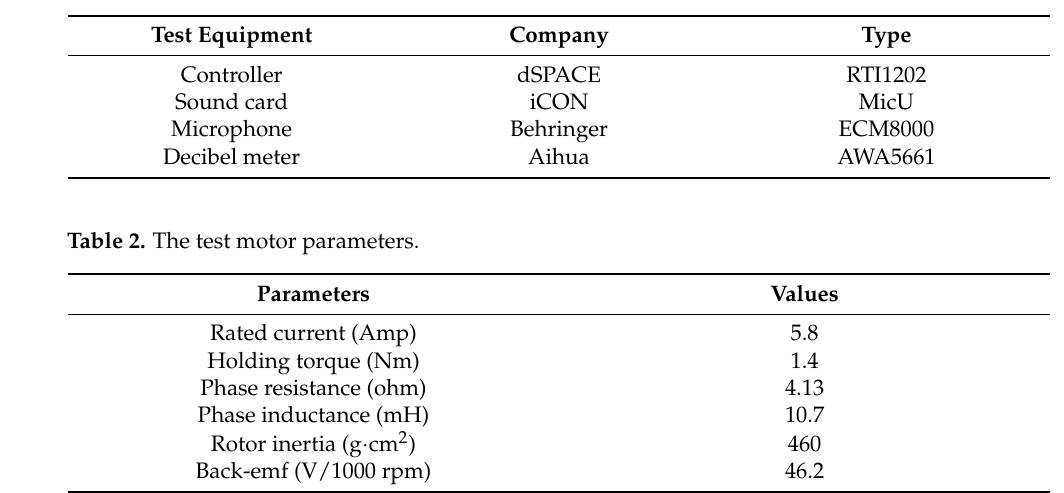
Figure 9. Testing result: the waveform of the drive current: ( a ) half-step subdivision mode in the loaded operation; ( b ) sensorless FOC mode in the loaded operation.